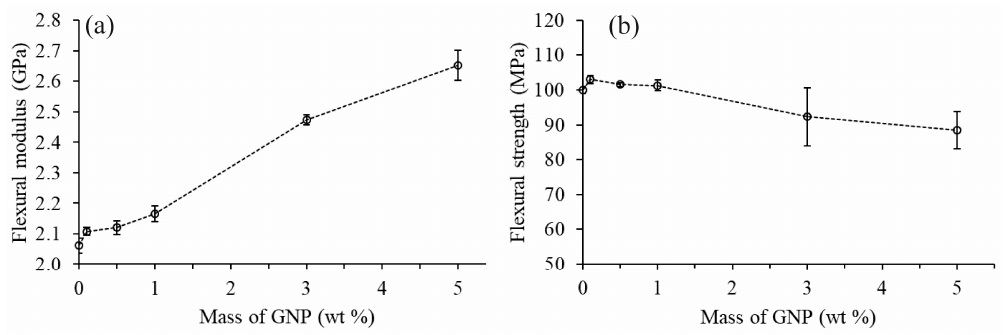
Figure 4. Effect of GNP on the ( a ) flexural modulus and ( b ) flexural strength of EP/GNP nanocomposites